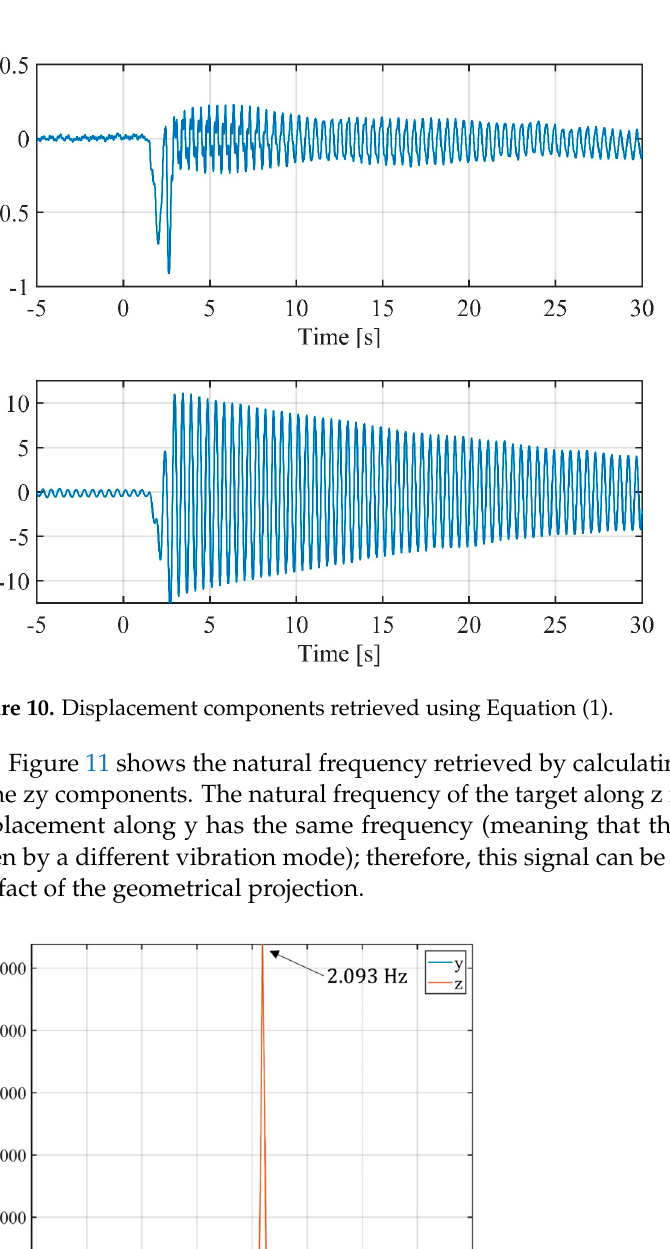
( b ) Figure 12. Experimental setup for verification of Equation (4): ( a ) picture of experimental setup, ( b ) block scheme used. Figure 13 shows the image obtained using the radar and transponder. The signal of the transponder was about 14 dB larger than the signal of the radar. This value almost corresponds to the PB estimated using Equation (4) and the scheme of Figure 12b.